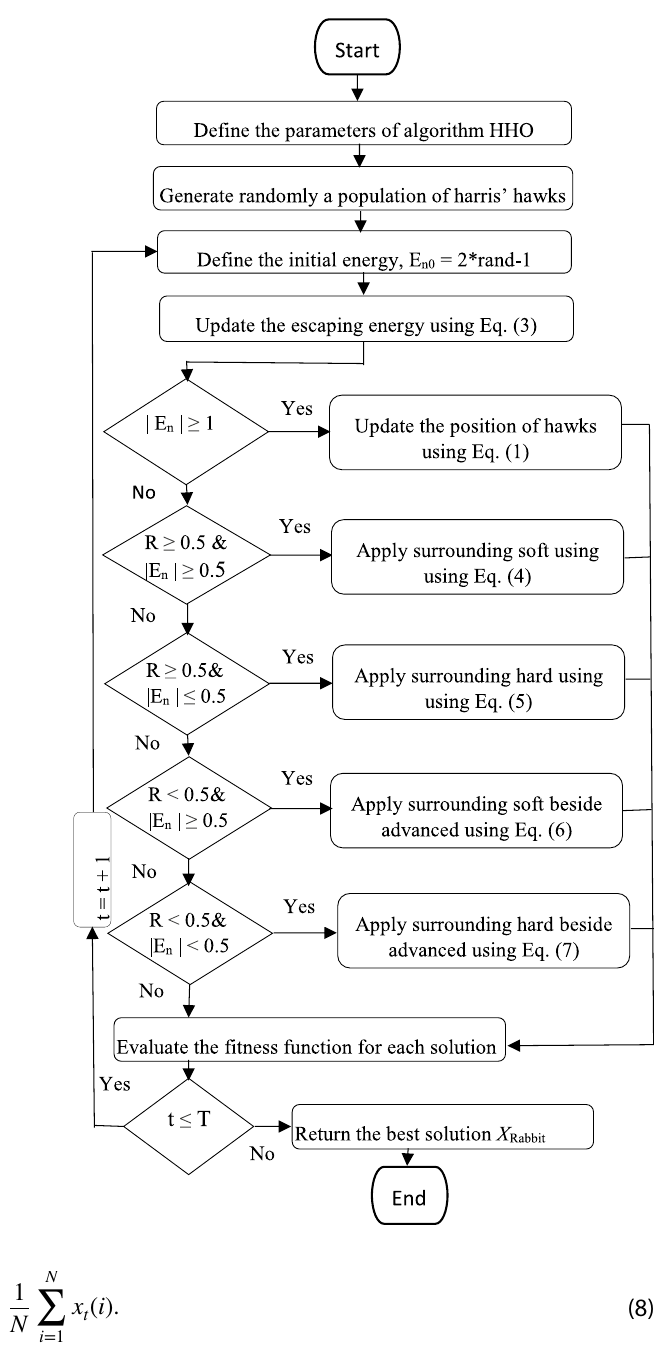
Fig. 1 Flowchart of the HHO